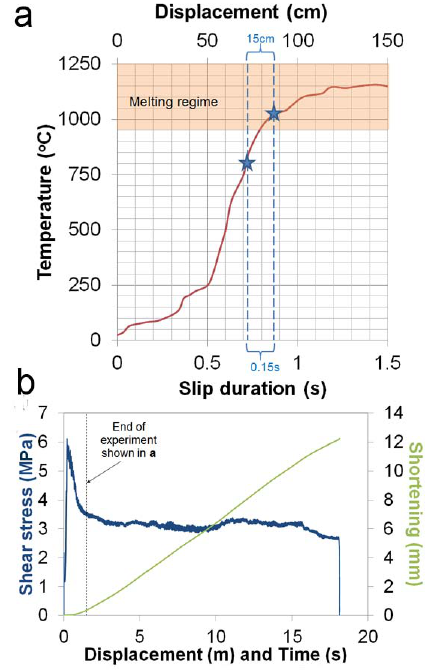
Fig. 10. Frictional melting of SHV andesite using a high velocity ro- tary shear apparatus. (a) Increasing temperature with time and slip distance at 10MPa normal load and 1.0ms − 1 slip velocity. Tem- perature was recorded using H2640 NEC \ Avio at a resolution of 90µm × 90µm per pixel with no correction for melt cooling. Start- ing from room temperature melting is achieved in 0.75s (75cm). The blue stars represent the change in temperature that results from a slip episode of 15cm in 0.15s (displacement parameters calcu- lated from the seismic events at SHV in Fig. 9) from a starting magmatic temperature of 800 ◦ C, where the magma temperature is increased by friction to 1025 ◦ C in that interval, with the onset of melting occurring at approximately 950 ◦ C (see also supplementary video). (b) Shear resistance (MPa) with slip duration and displace- ment during the experiment showing rapid increase in resistance as melting begins, followed by a peak as a full melt layer forms and attainment of steady state as melt supply rate and melt ejection (shortening)